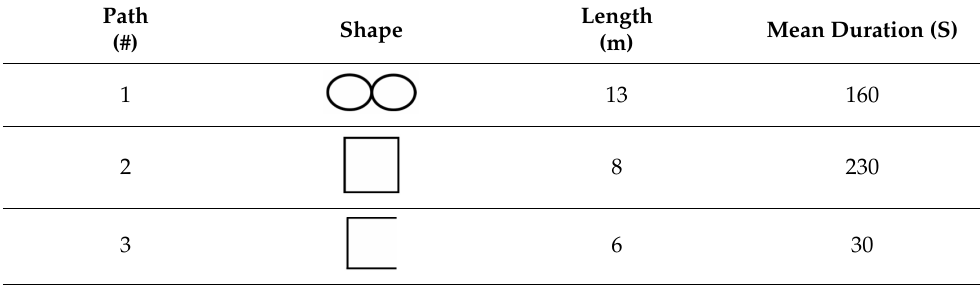
Table 2. The three paths considered during the experimentation field.